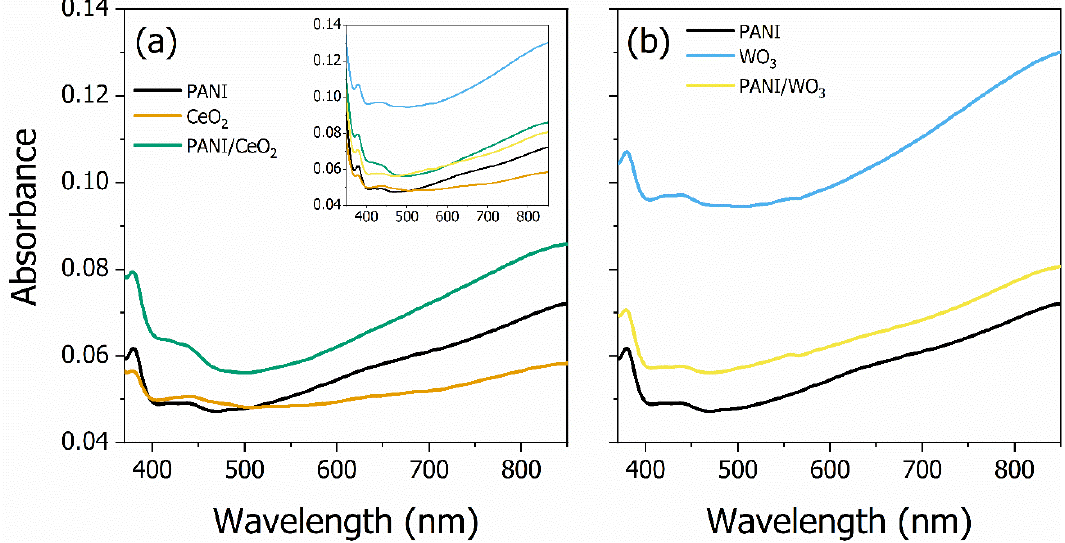
Figure 3. UV-VIS absorption spectra of all the thin films investigated in this work. The CeO 2 group (PANI, CeO 2 , and PANI/CeO 2 thin films) and WO 3 group (PANI, WO 3 , and PANI/WO 3 thin films) absorbance spectra are presented in ( a , b ), respectively. The ( a ) inset shows the entire spectra of PANI and its composites. The thin films’ absorbance changes with the presence of the metal oxide in the PANI matrix.